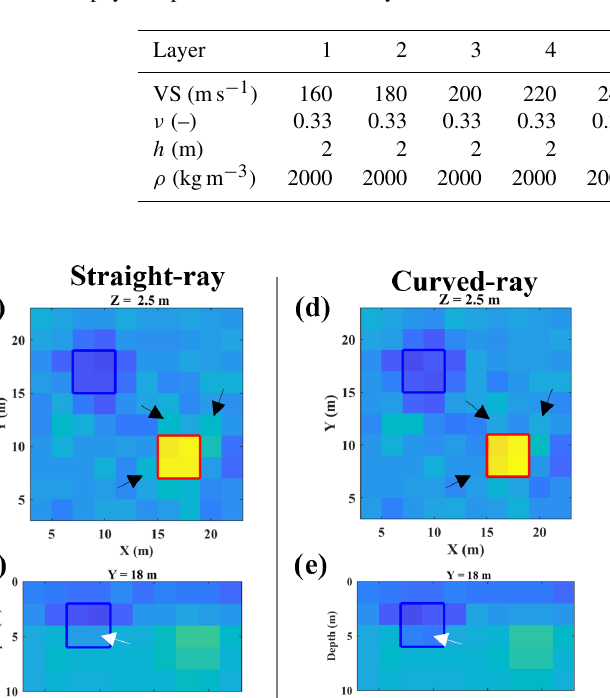
Table 1. Geophysical parameters of the Blocky model.